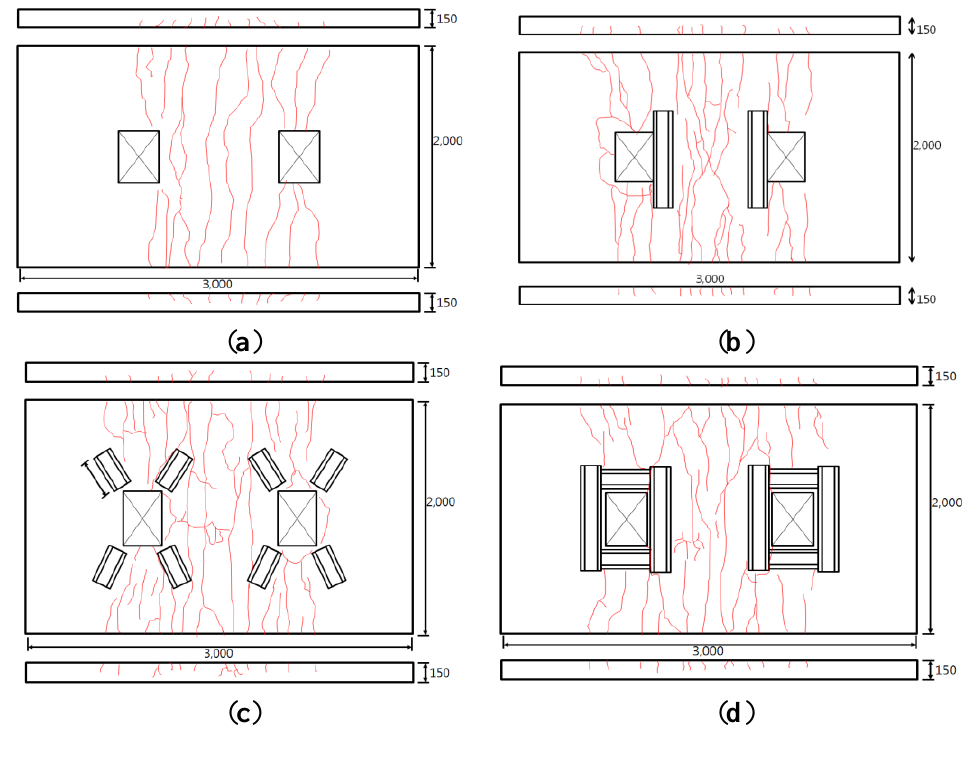
Figure 7. Crack patterns of ( a ) unstrengthened; ( b ) parallel strengthening; ( c ) diagonal strengthening; ( d ) surround